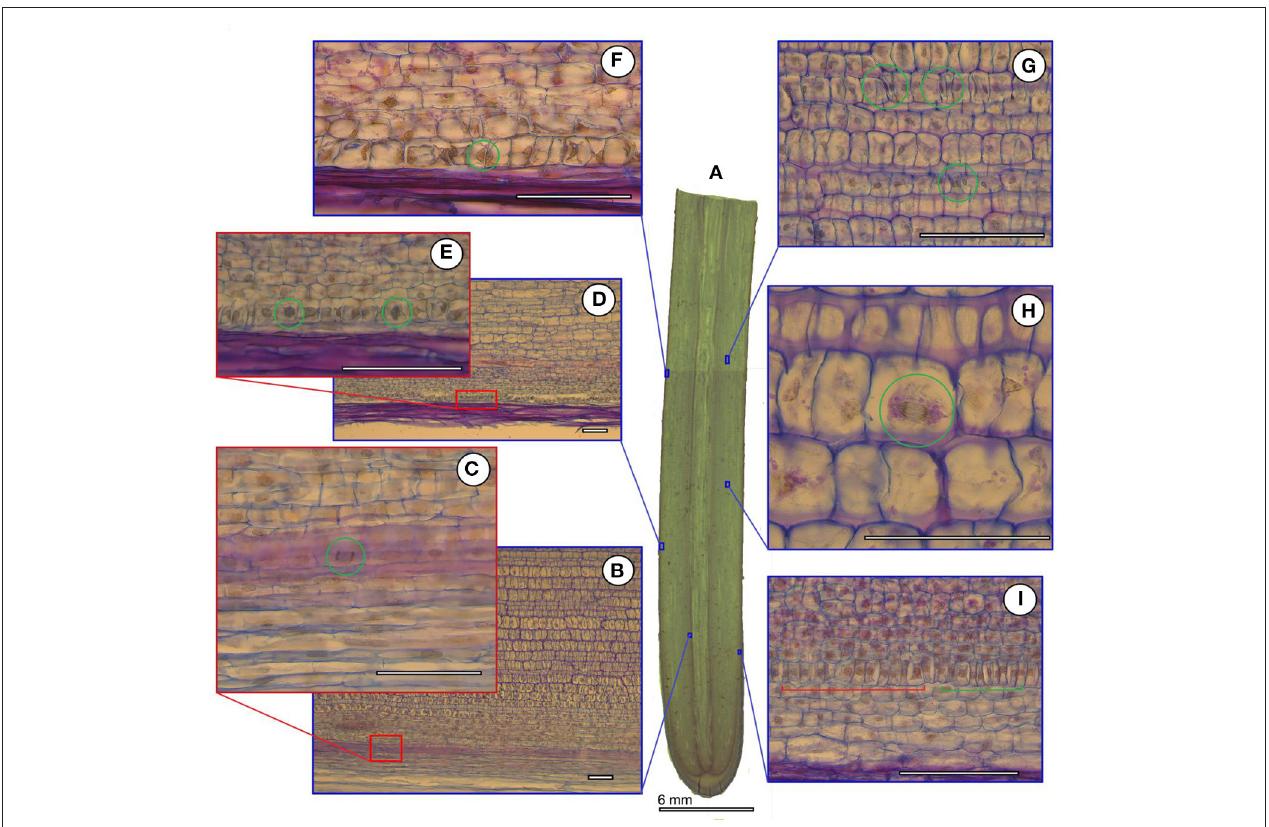
FIGURE 6 | Direct and indirect evidence of continuing cell divisions in a single growth zone on the example of Monstera deliciosa : (A) general view of a large root at minimum magnification—an accumulation of proliferating cells is visible as dark veins rising along the length of the root along the rhizoderm and pericycle with separate accumulations in the stele and cortex; in the cortex at the pericycle boundary (B) , growth and divisions (C) occur simultaneously (hereinafter, evidence of divisions is marked by green circles); the rhizoderm (D) is characterized by numerous alternating areas of increase due to growth by extension and decrease in length due to synchronous divisions (by E in the telophase stage); the same pattern is observed in areas of the rhizoderm much lower along the length of the root (F) ; in the cortex, areas with longer cells are interspersed with recently divided short cells (G) , dividing cells may occur in the anaphase stage (H) , in addition, areas with longer cells (marked in red) precede shorter cells (marked in green), which indicates change of the period of growth by periods of divisions (I) . Excluding the overview image in all cases, the scale is 100 µ